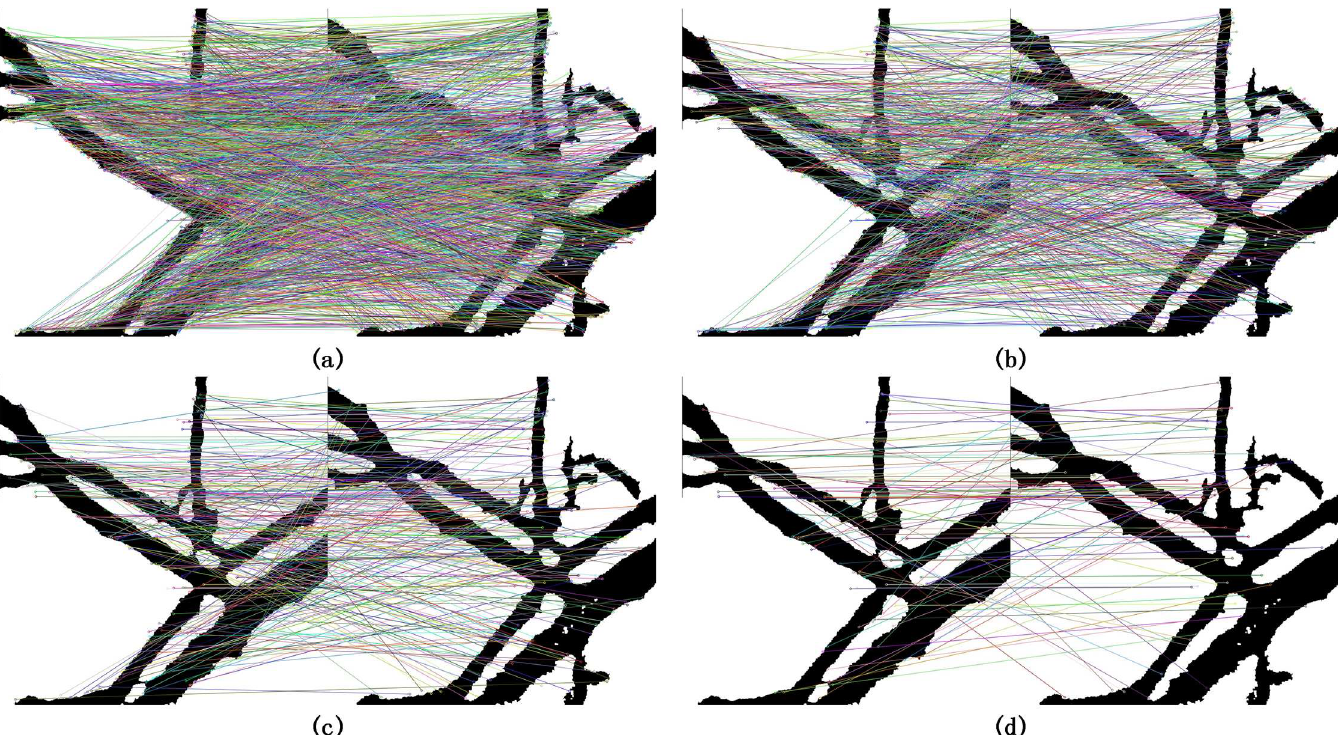
Fig 4. (a) Raw matches of initial method, (b) Raw matches of proposed method with 3 bands, (c) Raw matches of proposed method with 5 bands, (d) Raw matches of proposed method with 60